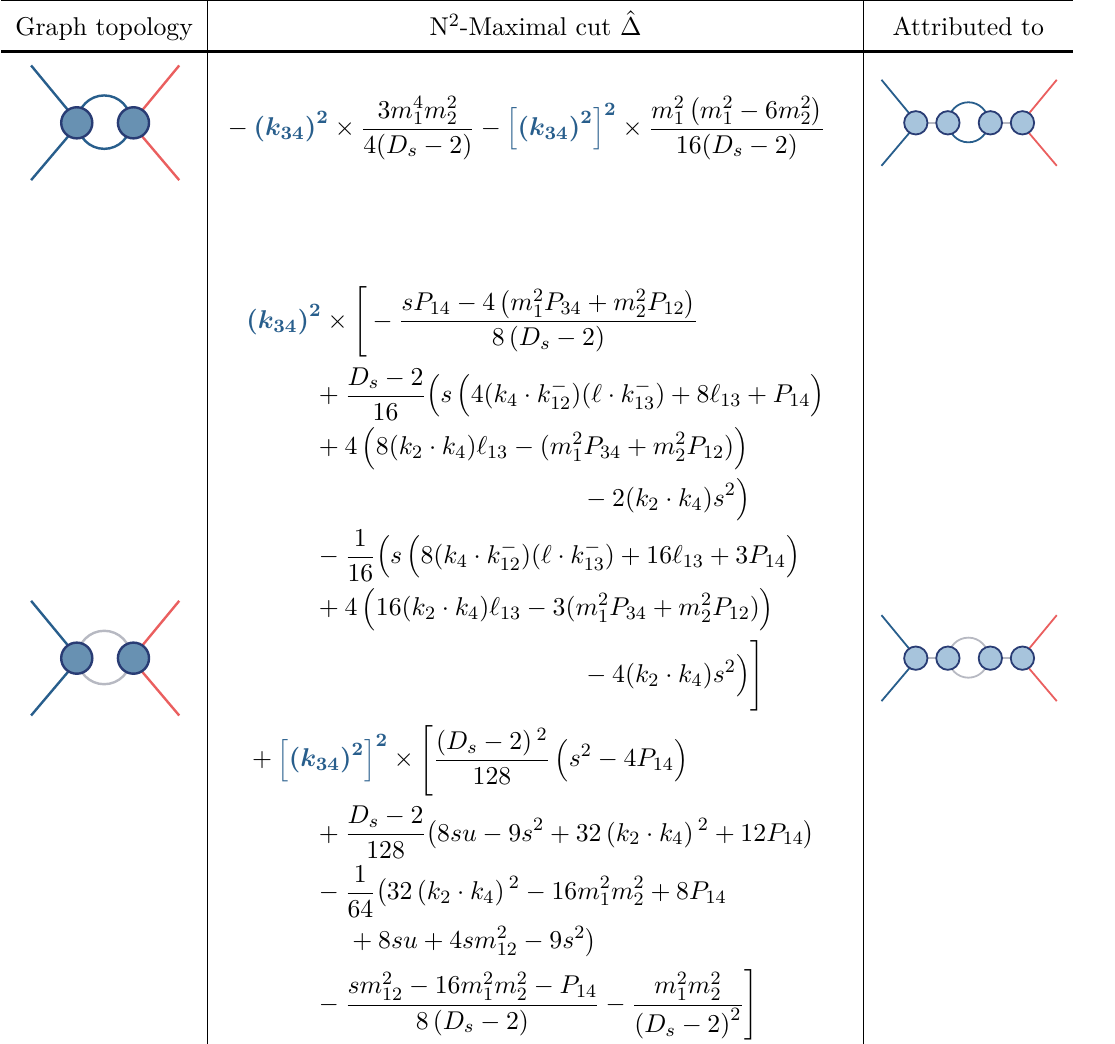
Table 6 . The symmetrized ˆ∆ contributions from the well-defined N 2 -maximal cuts of the one- loop four-point amplitude attributed to inverse propagators. Light blue blobs represent three- point amplitudes, darker blobs represent four-point amplitudes, and exposed legs represent on- shell propagators. Here ‘ 13 = ( ‘ · k 1 )( ‘ · k 3 ) , m 2 12 ≡ m 2 1 + m 2 2 , s ≡ ( k 3 + k 4 ) 2 , u ≡ ( k 2 + k 4 ) 2